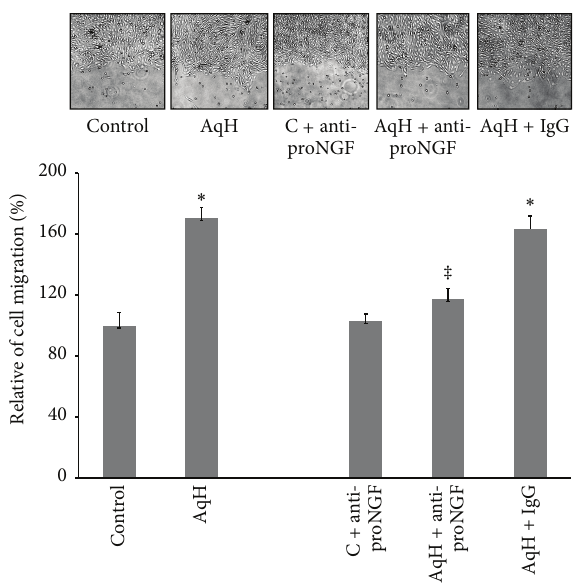
Figure 1: PDR-aqueous humor stimulates cell migration in a proNGF-dependent manner. HRE cells were grown to conflu- ence and then scratched using a standard cell scrapper. Cells were switched to serum free medium and treated with aqueous humor samples (10 𝜇 L/mL) in the presence or absence of either anti-proNGF antibody or rabbit IgG (1 𝜇 g/mL). Representative micrographs for wounded HME cells are shown after 18 hours of various treatments. Statistical analysis showed that aqueous humor increased mean cell migration by 1.8-fold compared to the control group. Addition of anti-proNGF antibody to aqueous humor sam- ples significantly reduced the mean percent of cell migration to the level of the control group whereas IgG did not significantly impact stimulatory effect of aqueous humor samples. Addition of anti- ProNGF antibody to control HRE cells did not significantly affect percent cell migration compared to control group ( ∗,‡ statistically significant compared to control and aqueous humor groups, resp., ( 𝑃 < 0.05 ), 𝑛 of aqueous humor samples = 7, 𝑛 of cell cultures =